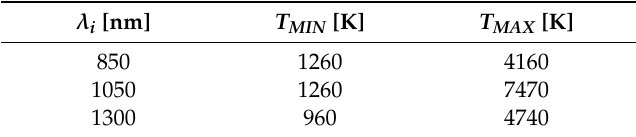
Table 2. Minimum and maximum measurable